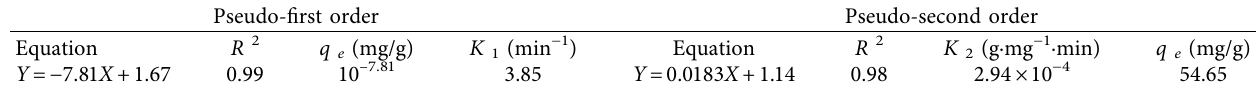
Table 6: Adsorption kinetics.